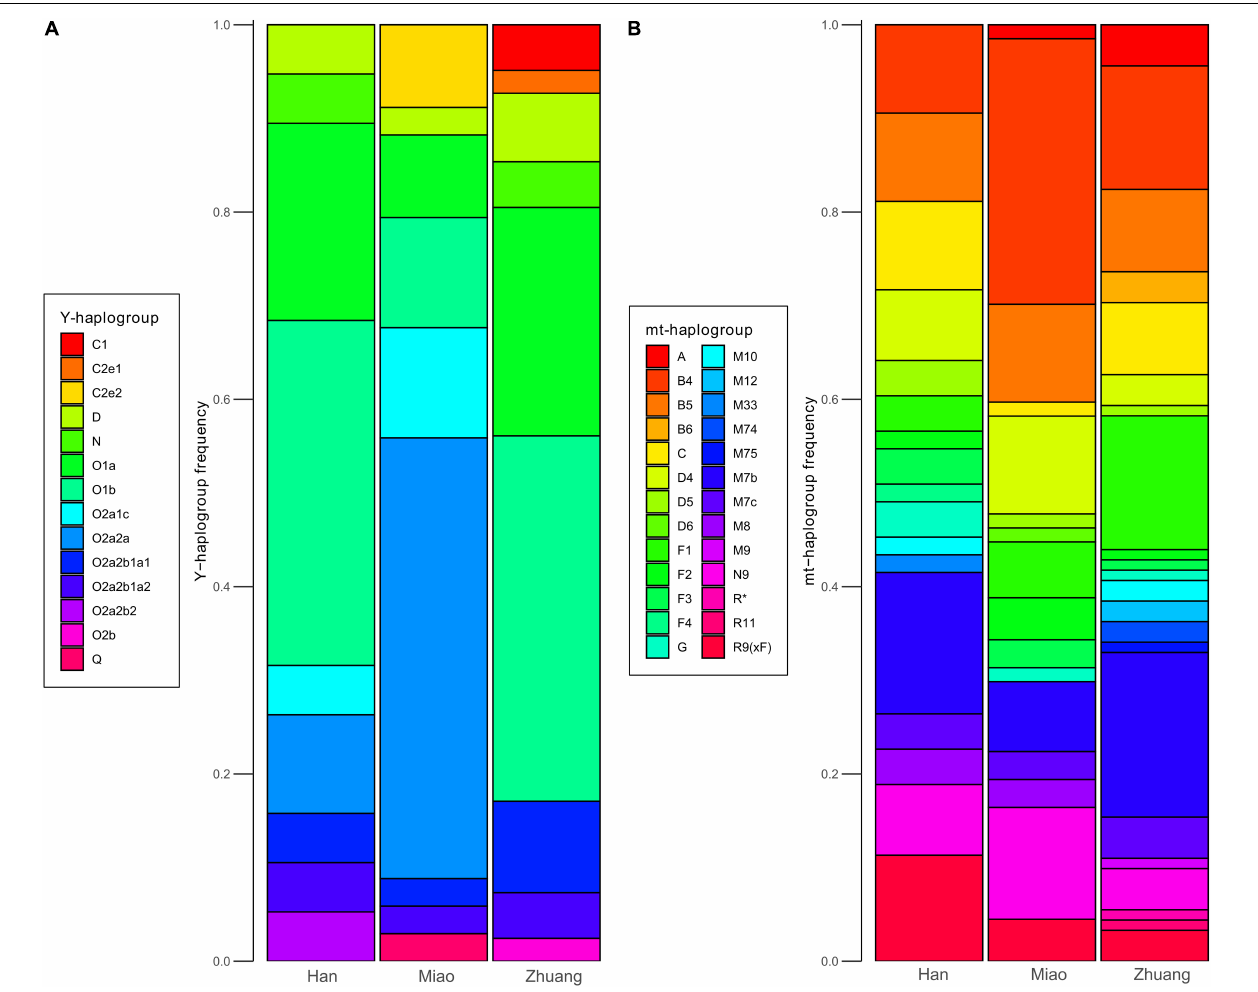
FIGURE 7 | Frequencies of uniparental markers in newly sampled populations. (A) Distribution of Y-chromosomal haplogroups in newly sampled Han ( N = 19), Miao ( N = 34), and Zhuang ( N = 41) populations. (B) Distribution of mitochondrial (mt) haplogroups in newly sampled Han ( N = 53), Miao ( N = 67), and Zhuang ( N = 91)